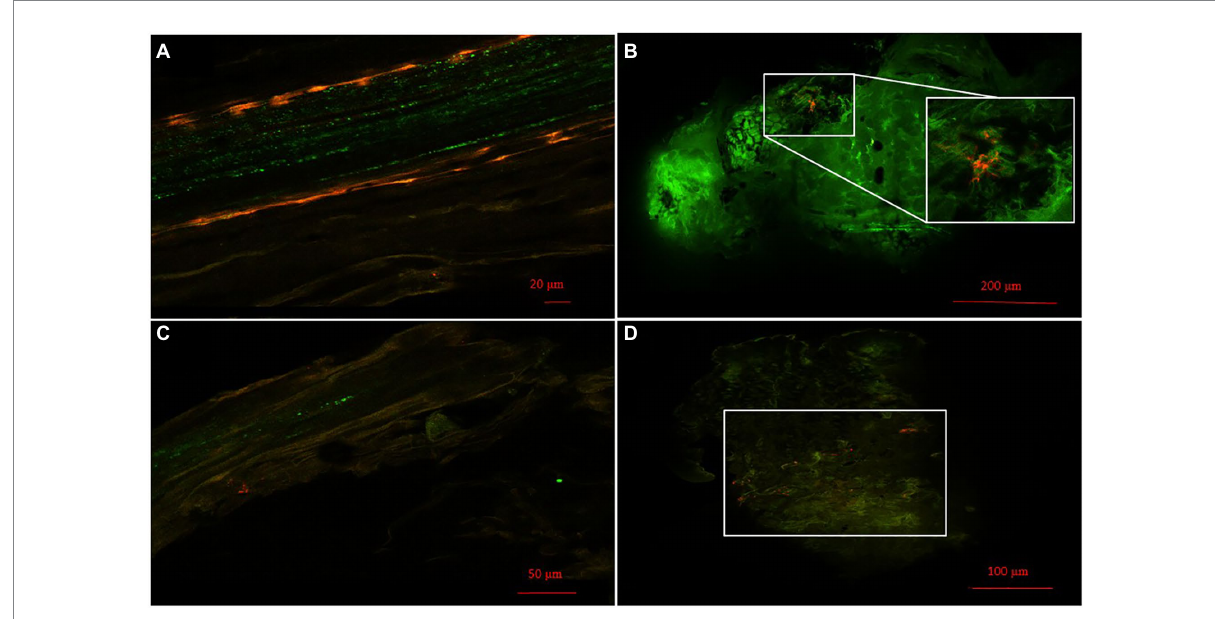
FIGURE 2 Bacterial colonization. (A) Images of roots and (B) nodules of colonized M. sativa 28 days after inoculation with Pseudomonas sp. N4 marked with mCherry and Ensifer sp. N10. (C) Images of roots and (D) nodules of colonized M. sativa 28 days after inoculation with Pseudomonas sp. N8 marked with mCherry and Ensifer sp. N10. The white square in (B,D) marks a group of Pseudomonas sp. N4 and Pseudomonas sp. N8, respectively, in the nitrogen fixation